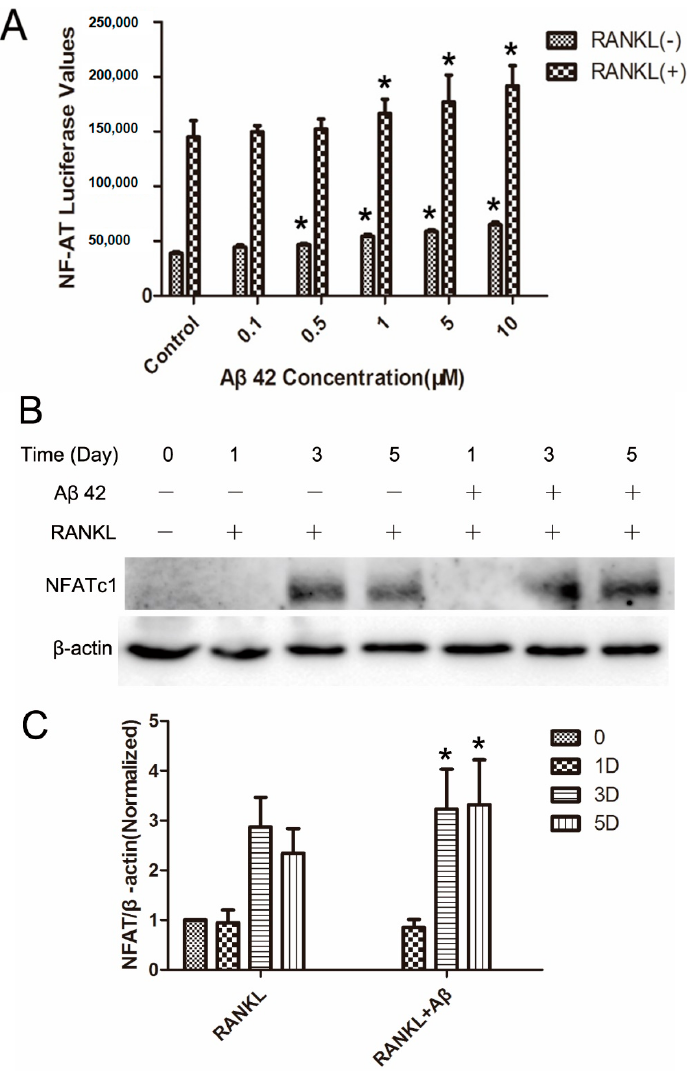
Figure 4. A β 42 enhances NFAT activity and protein expression of NFATc1 during osteoclast differentiation. ( A ) RAW264.7 cells stably transfected with a NFAT transcriptional luciferase reporter construct, were pretreated with A β 42 (0.1, 0.5, 1, 5, and 10 μ M) for 1 h and then stimulated with 50 ng/mL RANKL for 24 h ( n = 3). * p < 0.05 vs. control group; ( B ) Representative blots of cell lysates for NFATc1 and β -actin expression. BMM cells were pretreated with 5 μ M A β 42 for 1h prior to 100 ng/mL RANKL stimulation for 0, 1, 3, and 5 days; ( C ) Average ratio of NFAT relative to β -actin. Western blot signal intensities were quantified using Image J. NFAT-c1/ β -actin ratios were normalized to 0 day, results are presented as mean ± SD. “D” in C stands for Day. * p < 0.05 vs. control group with RANKL treatment only at the corresponding time